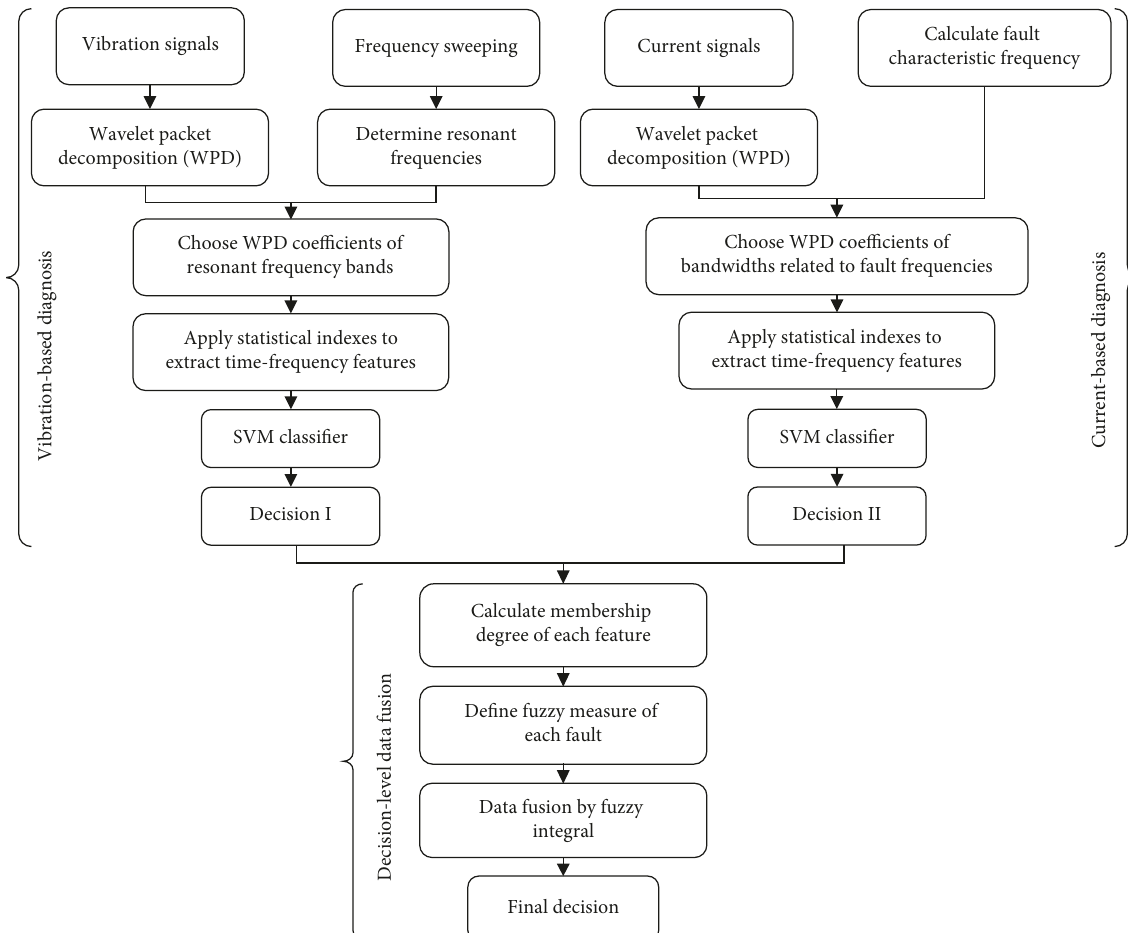
Figure 2: Flow chart of the proposed method.